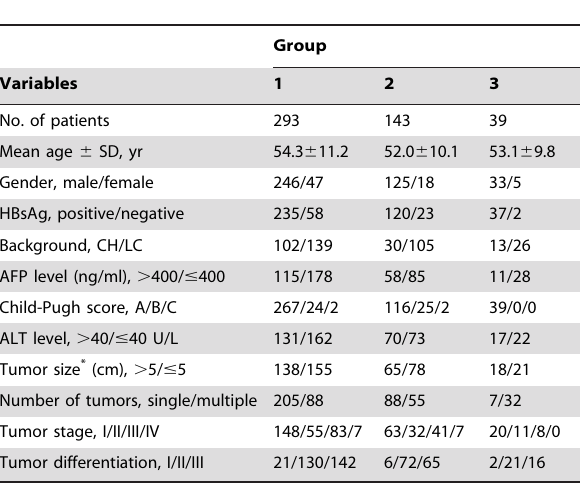
Table 3. Characteristic of Patients with HCC.